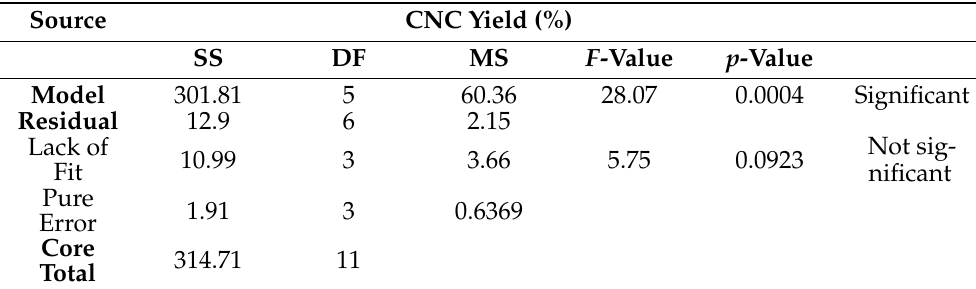
Table 3. ANOVA for the chosen quadratic model to optimize apricot pomace CNC extrac- tion yield (%).